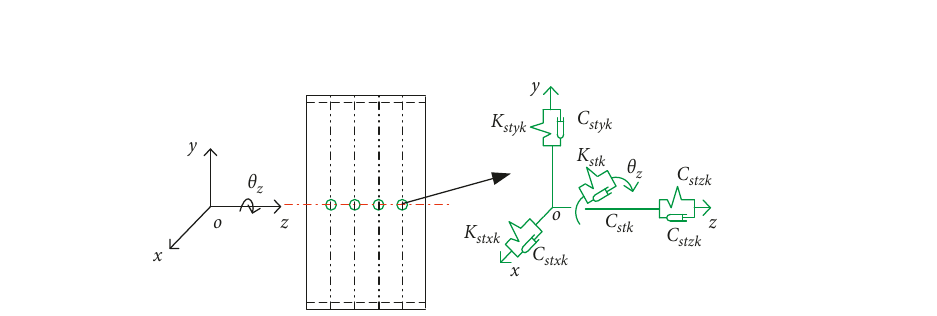
Figure 2: The mechanical model of a 5 equal slicing type